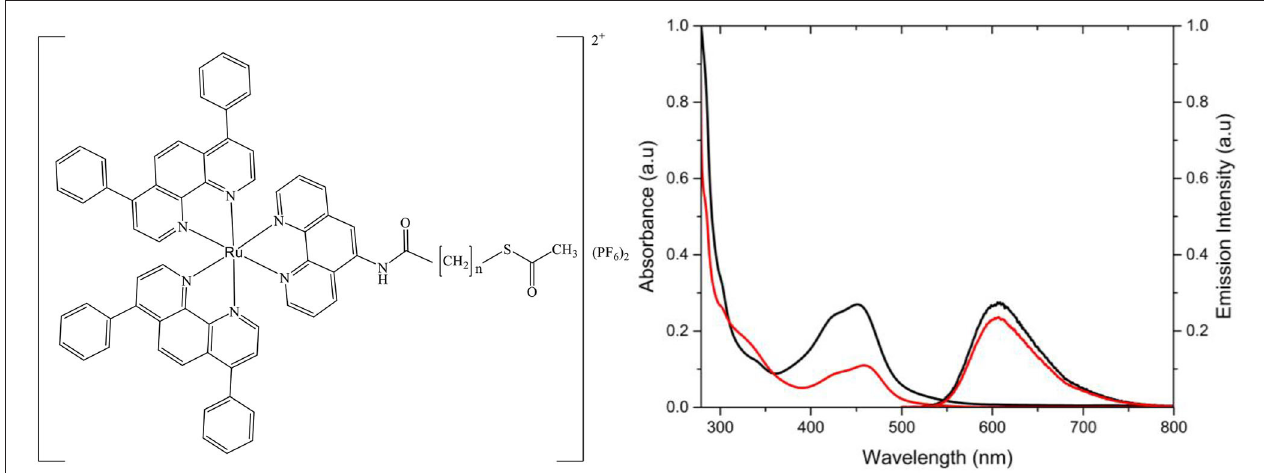
FIGURE 1 | Structure of [Ru(dpp) 2 (16-ATAP)](PF 6 ) 2 where x is the number of carbons in the aliphatic chain, resulting in [Ru(dpp) 2 (16-ATAP)] 2 + or [Ru(dpp) 2 (11-ATAP)] 2 + . Absorbance and emission spectra of [Ru(dpp) 2 (11-ATAP)] 2 + ( __ ) and [Ru(dpp) 2 (16-ATAP)] 2 + ( __ ) in PBS (15 µ M, λ exc 454nm; slit width =